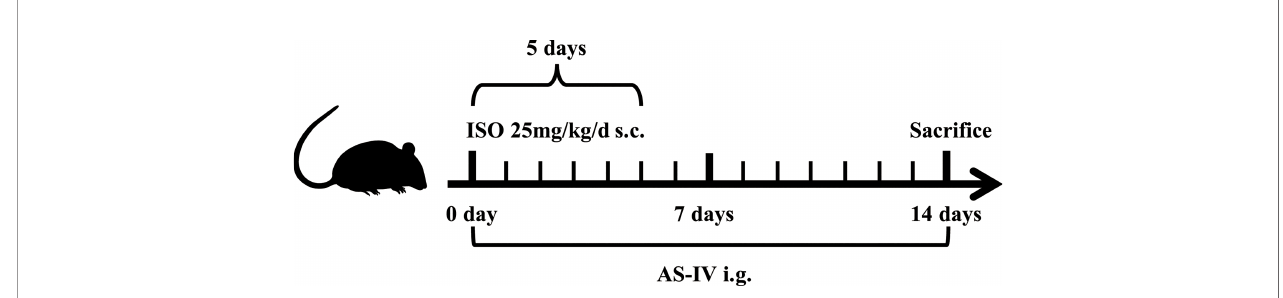
FIGURE 1 | Timeline of the experimental